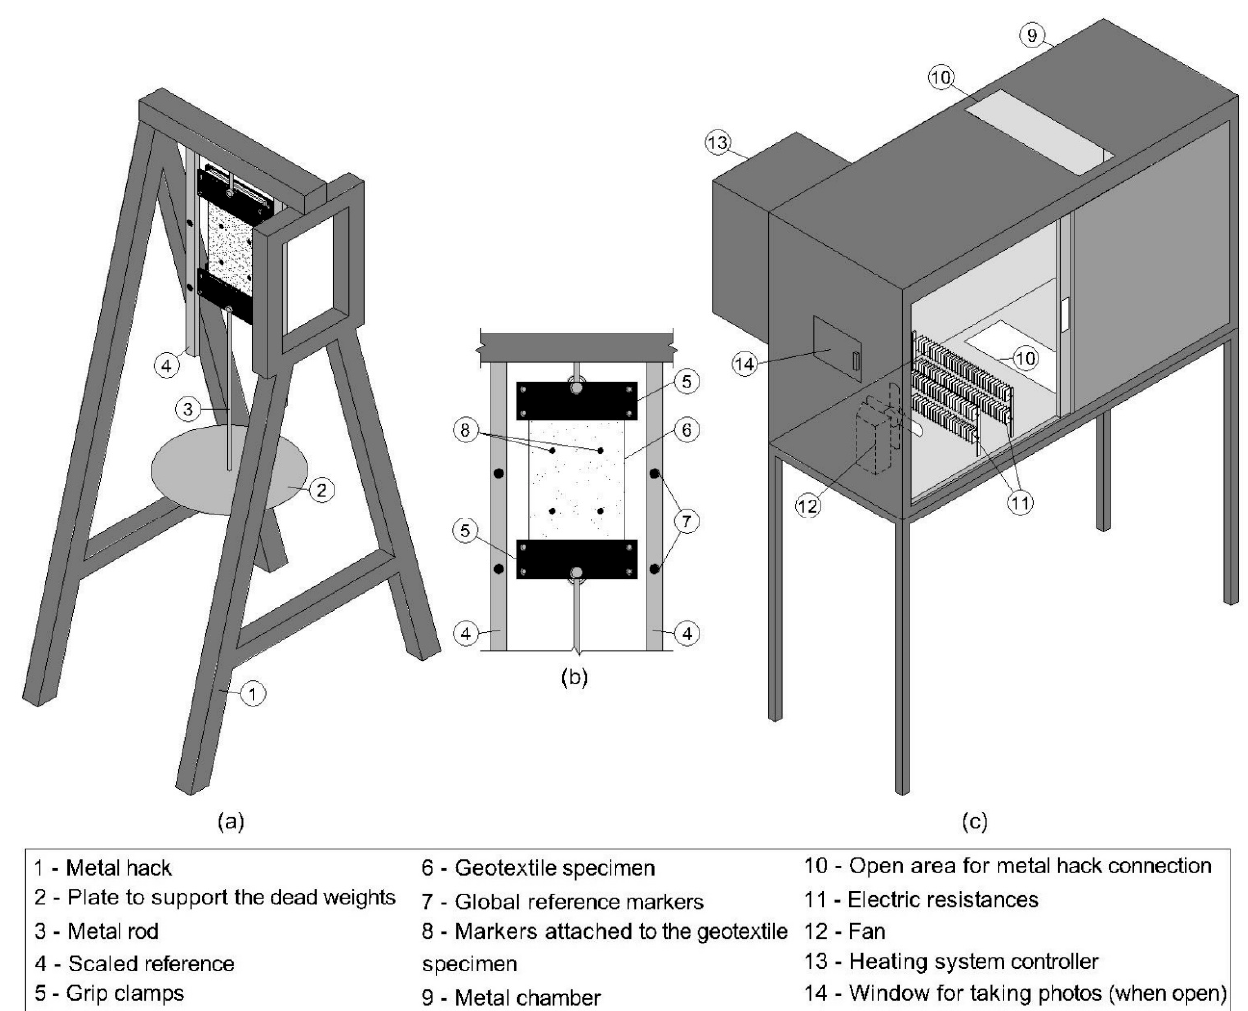
Figure 1. Schematic view of the ( a ) equipment to perform in-isolation (unconfined) creep tests, ( b ) close-up view of the geotextile specimen and reference markers to obtain the specimen’s strain, and ( c ) temperature-controlled chamber constructed to perform the accelerated creep tests.